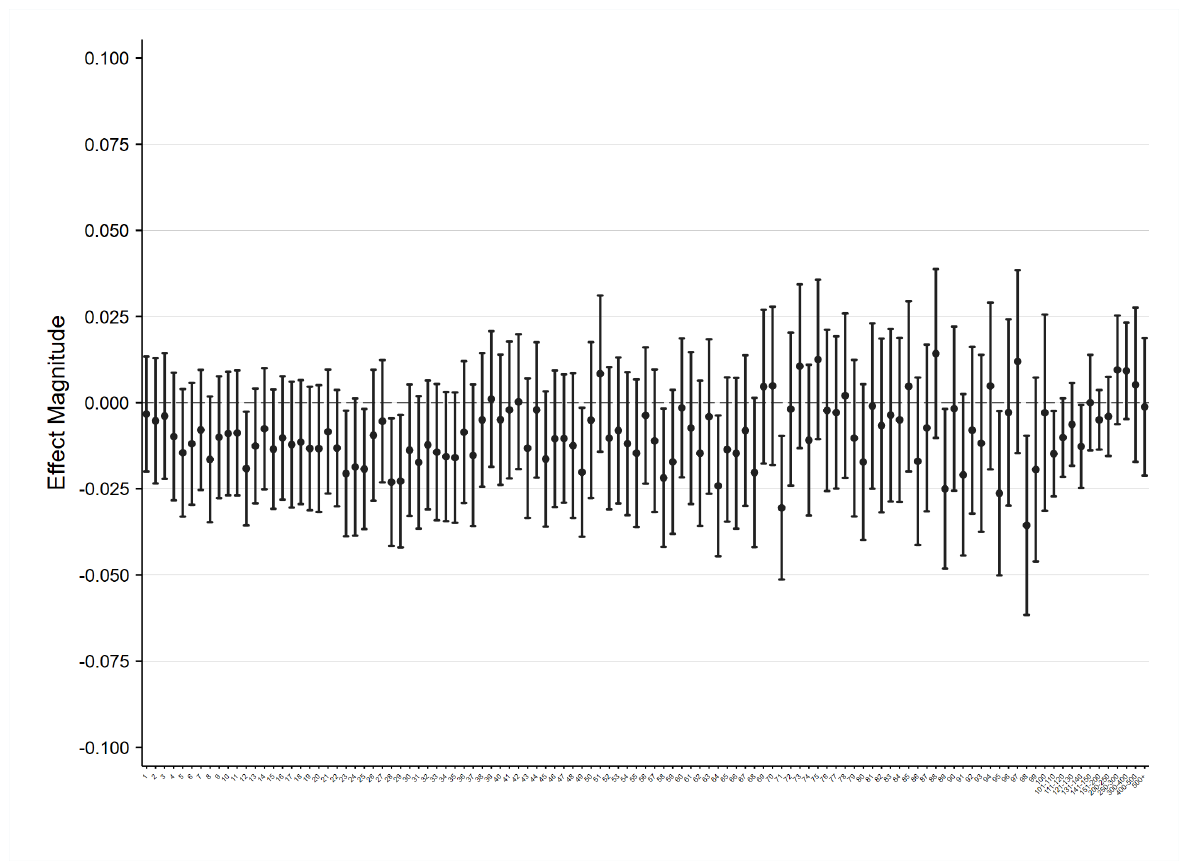
Figure 4: Gender × relatedness rank interactions. Notes : Figure 3 displays the coefficient estimates (and associated 95 percent confidence intervals) for the interaction effects between gender and relatedness rank in an expanded version of the specification appearing in Table 3, column 7. In these specifications, relatedness is broken down into 112 dummies: PMRA unrelated (the omitted category), PMRA related of rank 1, PMRA related of rank 2, ... , PMRA related of rank 100, 100 to 110, 110 to 120, 120 to 130, 130 to 140, 140 to 150, 150 to 200, 201 to 250, 251 to 300, 301 to 400, 401 to 500, and finally 501 to 10,000. These main effects of intellectual relatedness are further interacted with